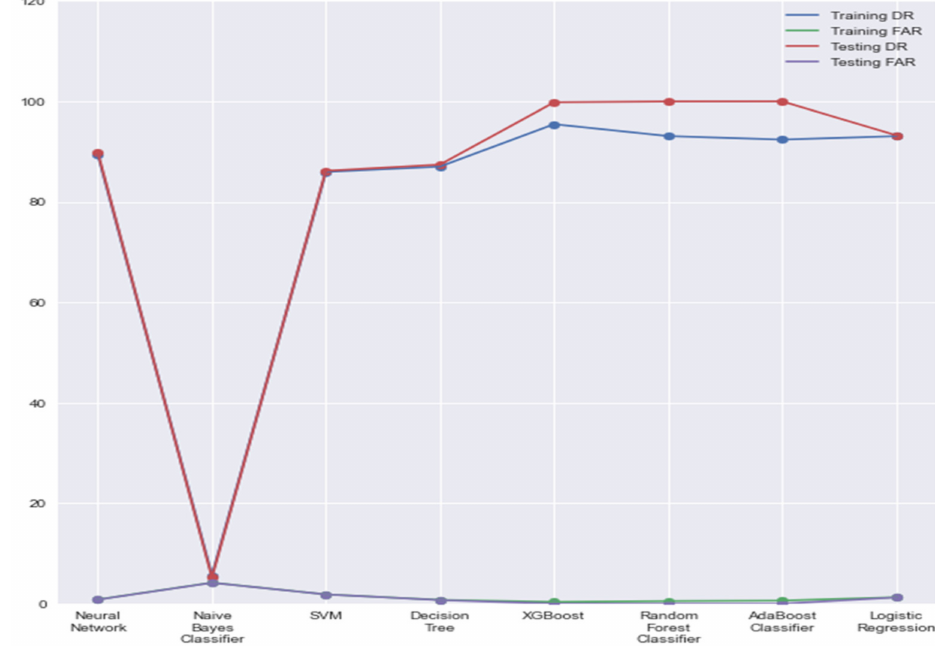
Figure 3. DRs and FARs of all models.